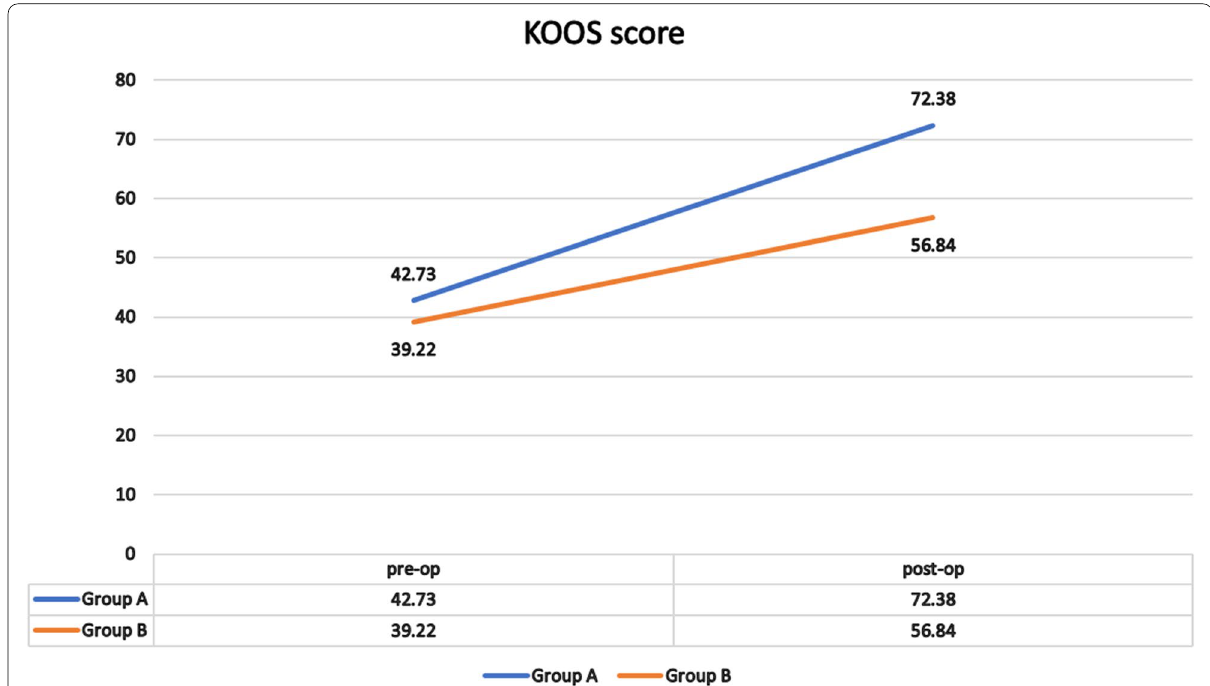
Fig. 15 Pre‑ and postoperative KOOS with % difference from baseline in both